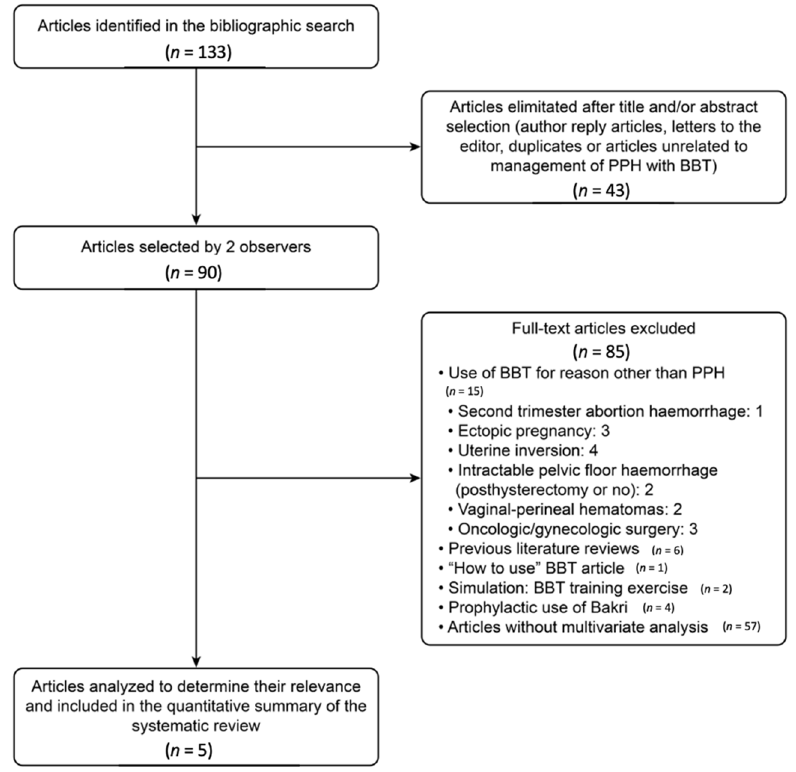
Figure 2. Flowchart to describe posterior management of Bakri Balloon Tamponade (BBT) failure cases.